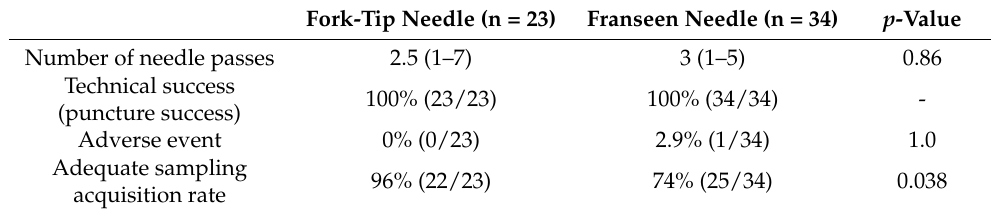
Table 2. Comparison of Procedure-related Performances of the Fork-tip and Franseen